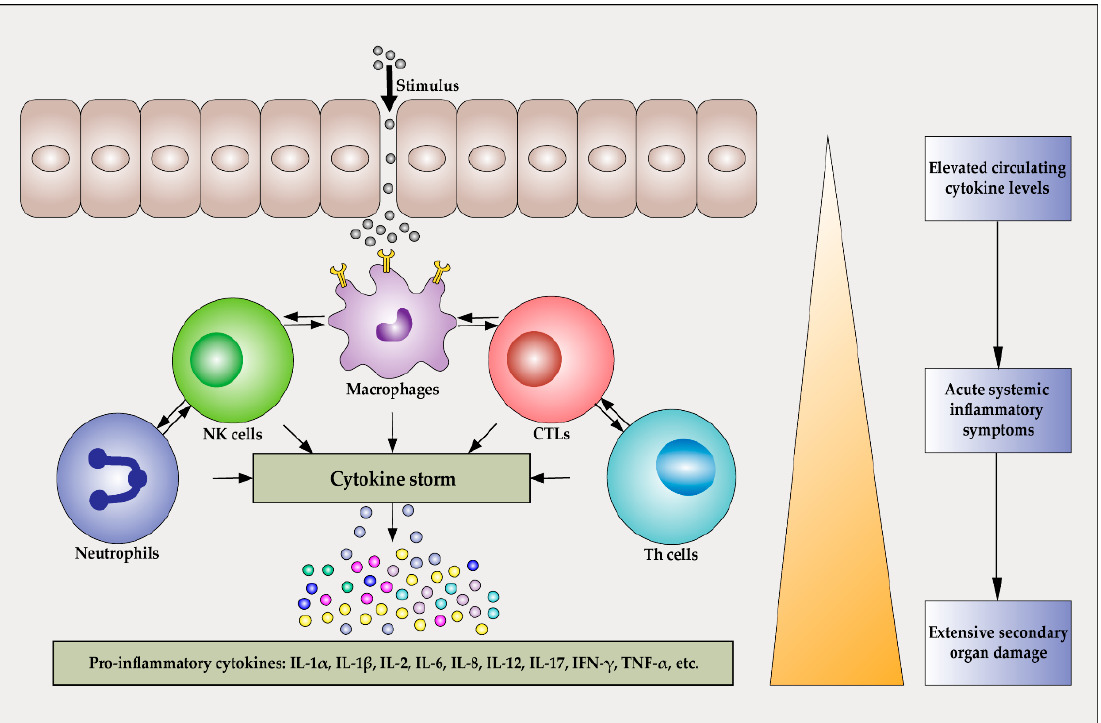
Figure 1. Cells that can be involved in a cytokine storm. Various types of cells, such as neutrophils, natural killer (NK) cells, macrophages, cytotoxic T lymphocytes (CTLs), and T helper cells (Th cells), are intimately involved in the initiation and progression of cytokine storms. These cells interact with each other and can influence each other’s activities.